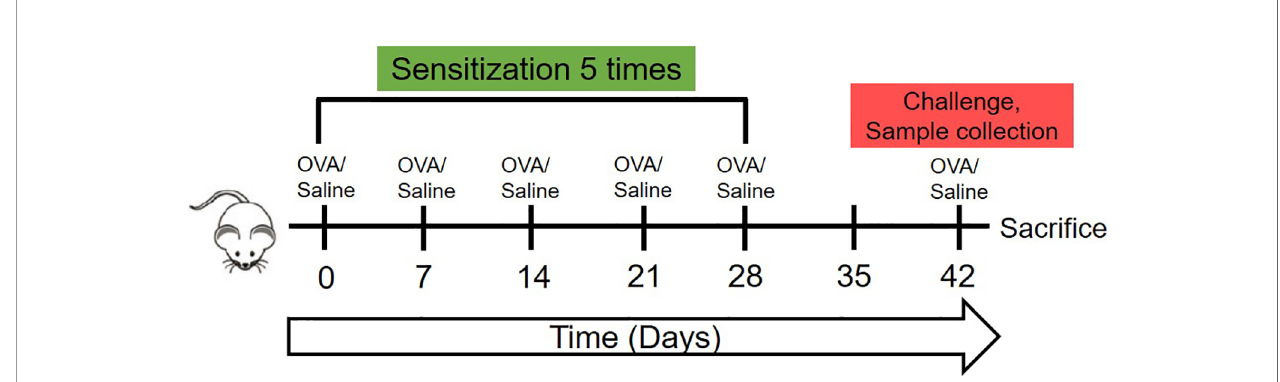
FIGURE 1 | The schematic of the animal experiment of this research. The 7-week-old female C3H/HeJ mice were sensitized once weekly in the fi rst 28 days with 1mg OVA dissolved in 200 ul saline or 200 ul saline by oral gavage. Then, on day 42, were orally challenged with 5mg OVA dissolved in 1 ml saline or 1 ml saline, followed by sera collection, temperature detection and sacri